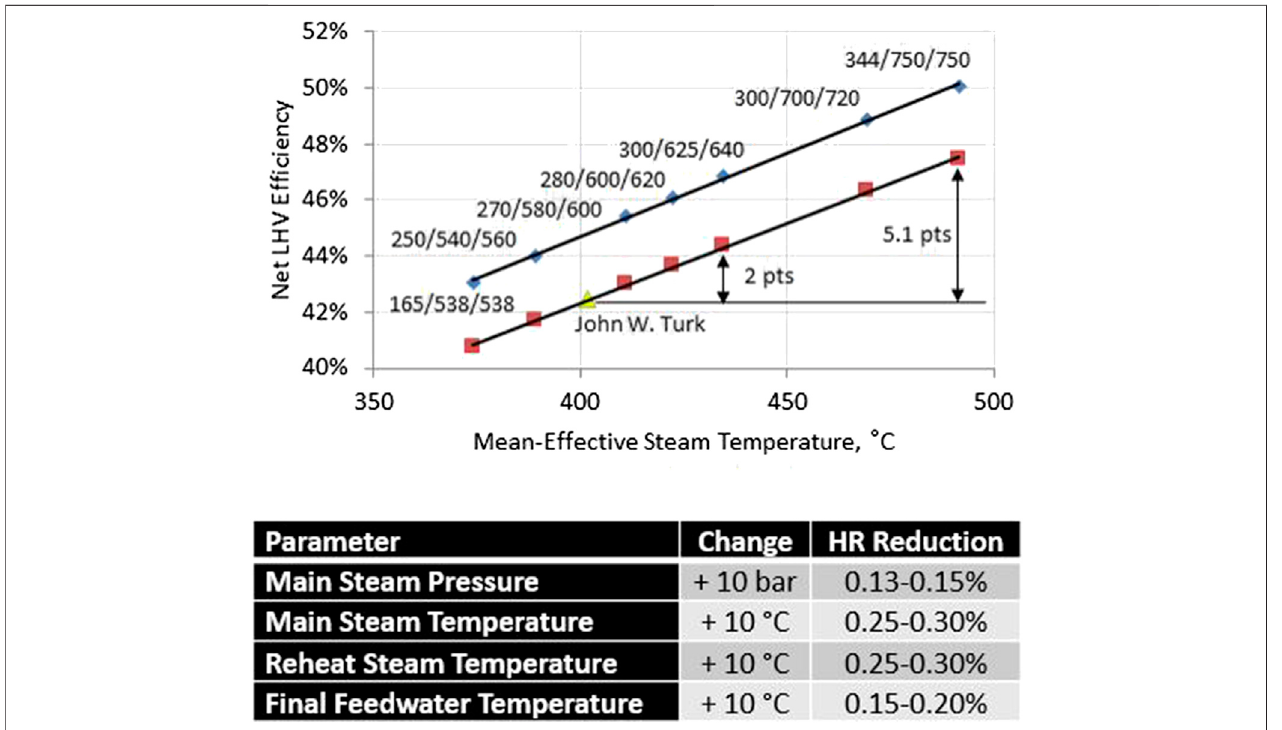
FIGURE 7 | Steam cycle impact on net plant ef fi